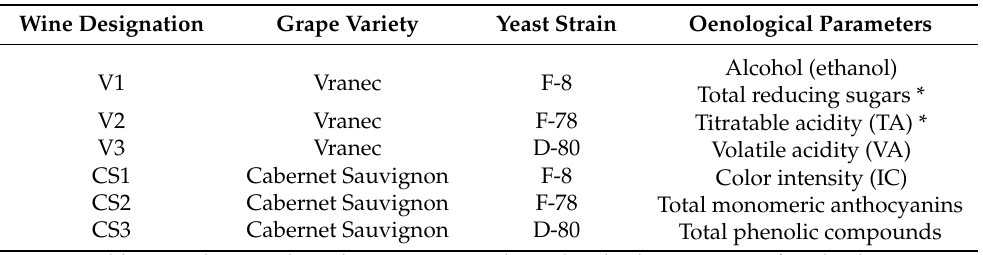
Table 1. Experimental design for the wines produced with Vranec and Cabernet Sauvignon grape varieties and fermented by autochthonous and commercial yeast